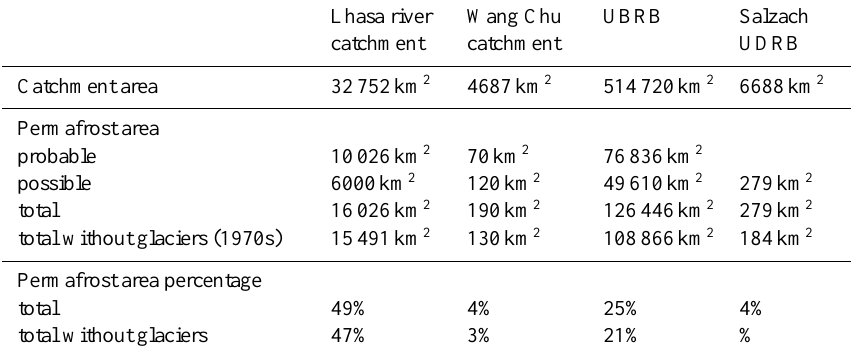
Table 2. Area distribution of permafrost.